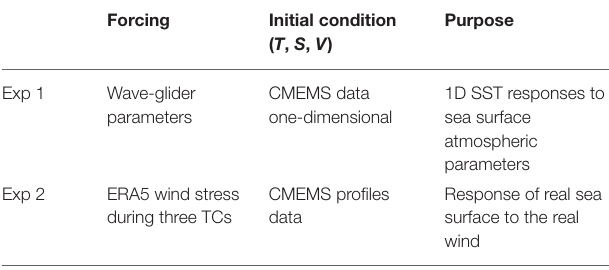
TABLE 2 | Three sets of numerical experiments.